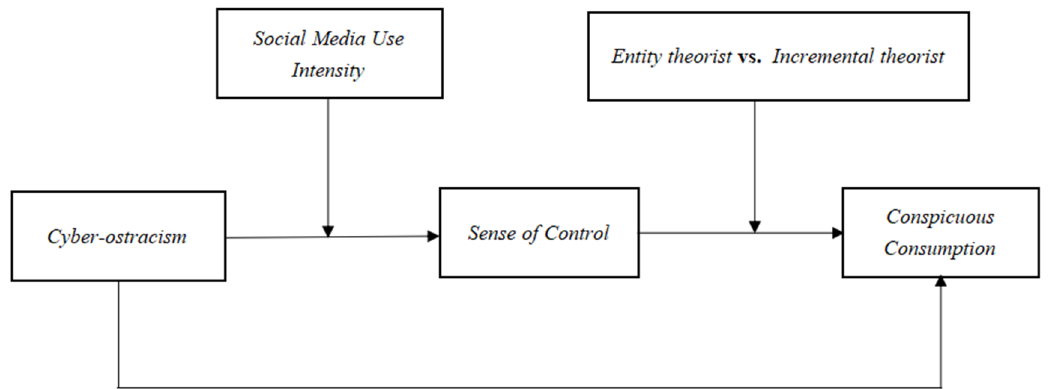
Figure 1. Conceptual model.